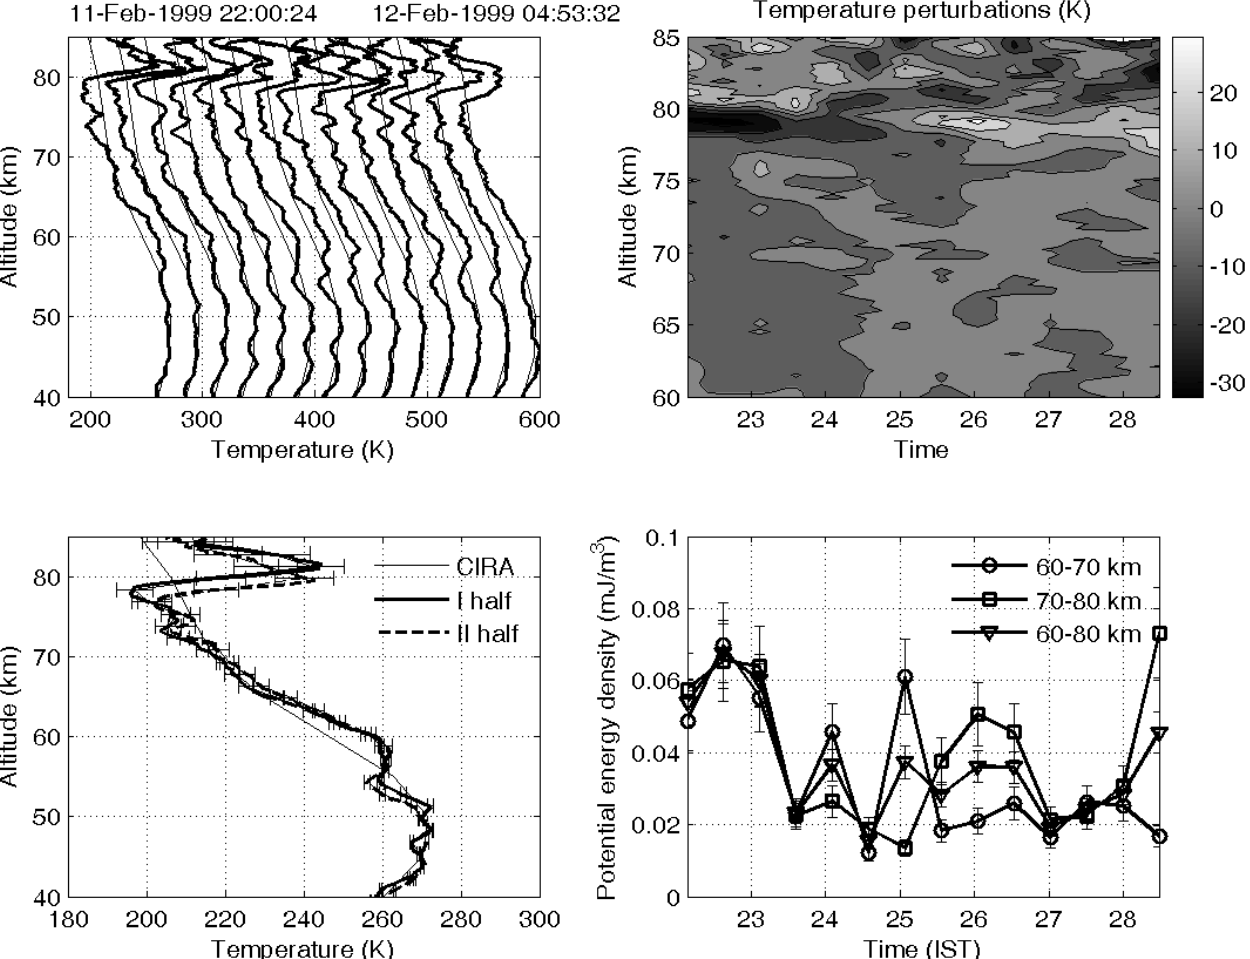
Fig. 3. Same as Fig. 1 except that it is for 11–12 February 1999.